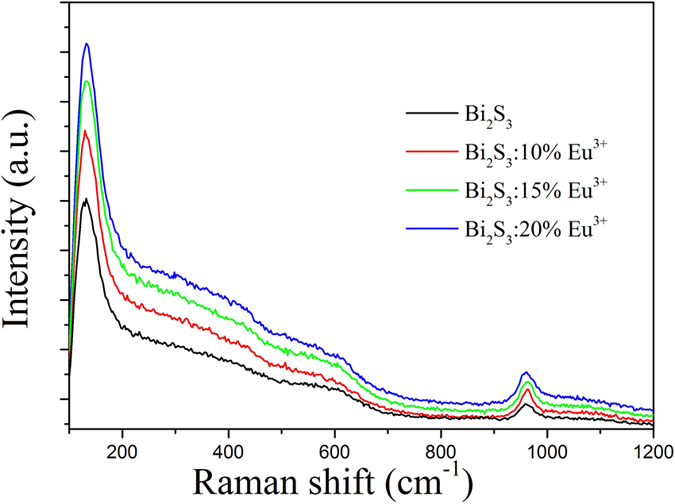
Raman spectra of Bi2S3:Eu3+ nanocrystals prepared at 180 °C for 12h with different Eu3+ concentrations.